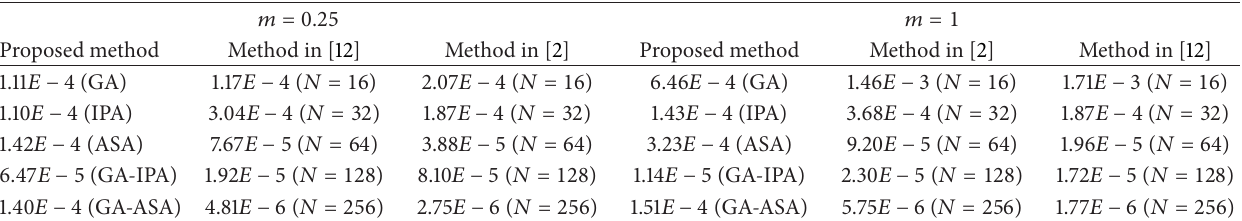
Table 7: Comparison of maximum absolute errors in solution of Example 2 between the proposed heuristic computing method and the methods given in [2, 12] (for 𝑚 = 0.25 , 1).